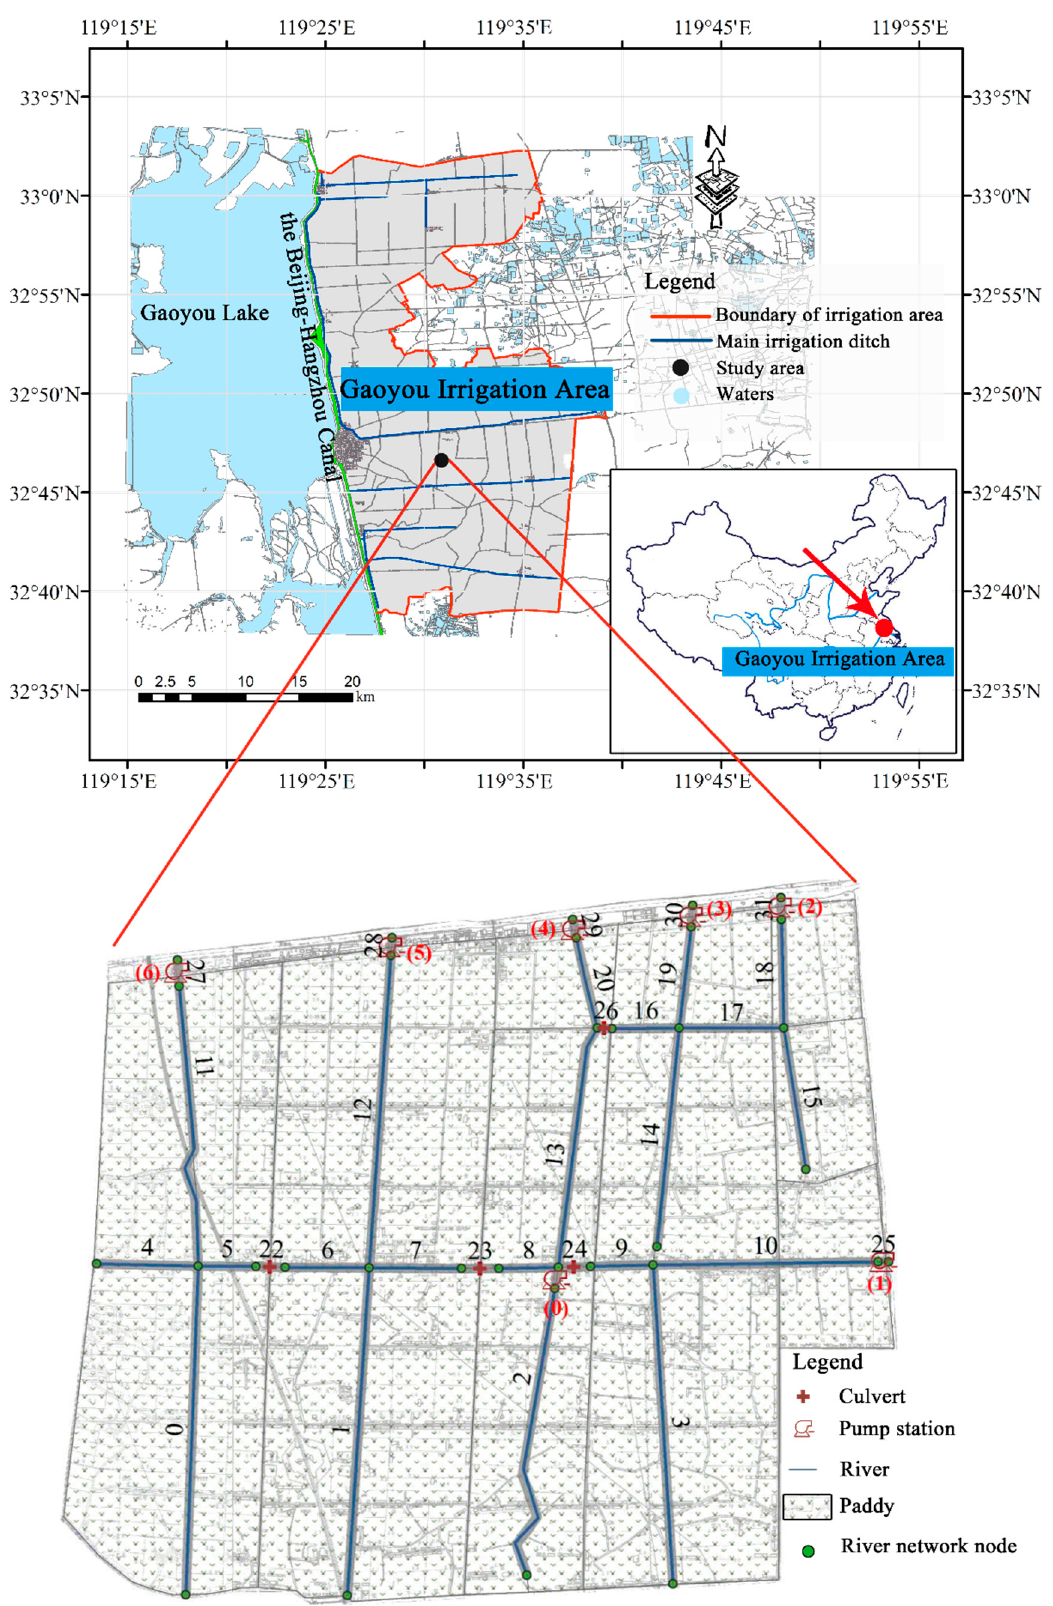
Figure 4. Study area map and drainage system generalization. (0)–(6) presrnts serial number of pump Station: (0). Heping, (1). Kouhe, (2). Nijia, (3). Hongqi, (4). Jiangmahe, (5). Zhongshihe, (6). Lvyanghe.